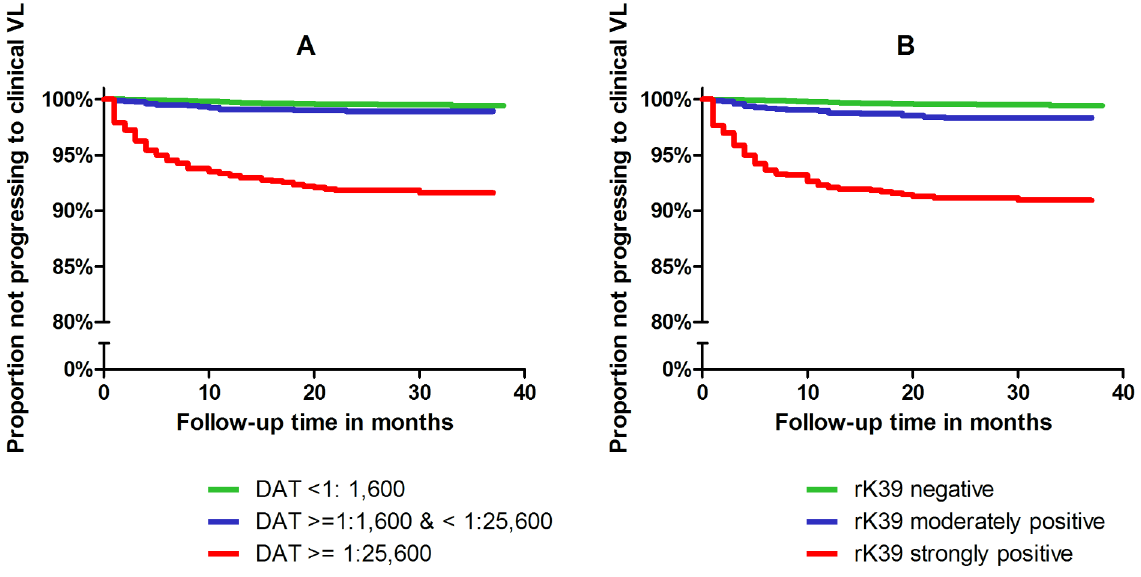
Figure 1. Risk of progression to clinical VL in groups with different levels of (A) DAT and (B) rK39 serologic titers in the baseline surveys. Data from all four cohorts were combined in generating these plots.